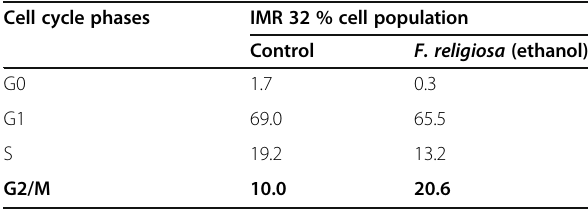
Table 6 The % cell population of IMR 32 cells at different phases of cell cycle Cell cycle phases IMR 32 % cell